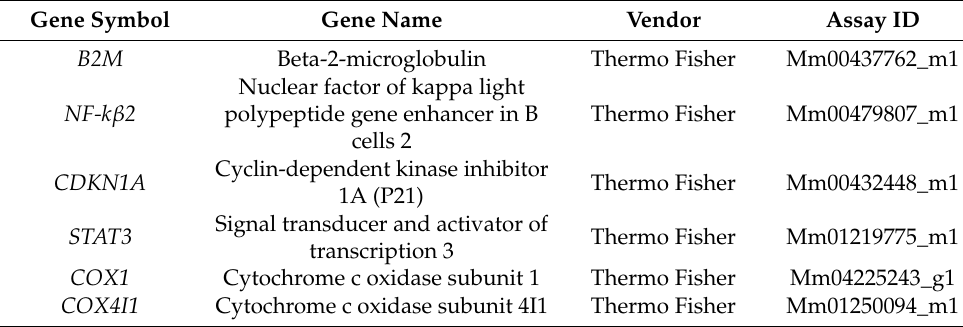
Table 3. TaqMan probe gene assay ID.